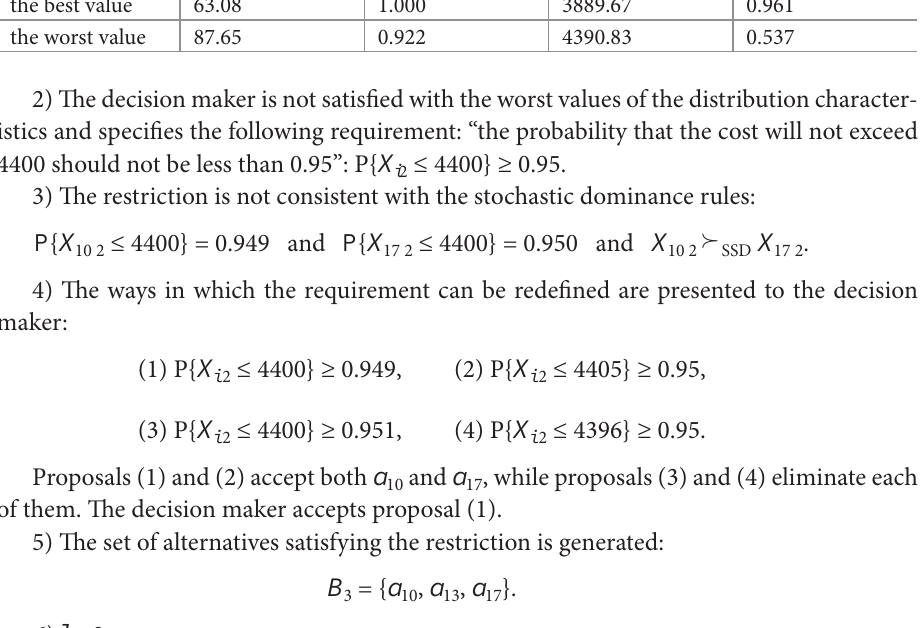
Table 5. Data presented to the decision maker at iteration 2 X 1 X 2 mean P{ X i 1 ≤ 95}